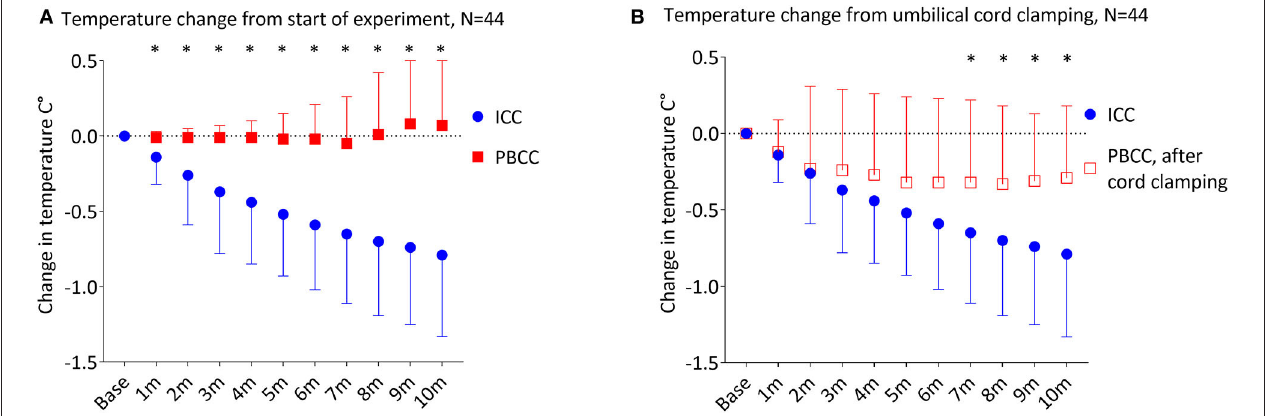
FIGURE 3 | (A) Change in temperature from the start of the experiment in lambs receiving immediate cord clamping (ICC) vs. physiologic-based cord clamping (PBCC) displayed in mean ± SD using two-way mixed ANOVA with Games-Howell post-hoc analysis. (B) Change in temperature from the time of umbilical cord clamping in lambs receiving ICC vs. PBCC displayed in mean ± SD using two-way mixed ANOVA with Games-Howell post-hoc analysis. ICC, immediate cord clamping; PBCC, physiological based cord clamping; m, minutes, *denotes significant difference ( p < 0.05) in temperature between groups.